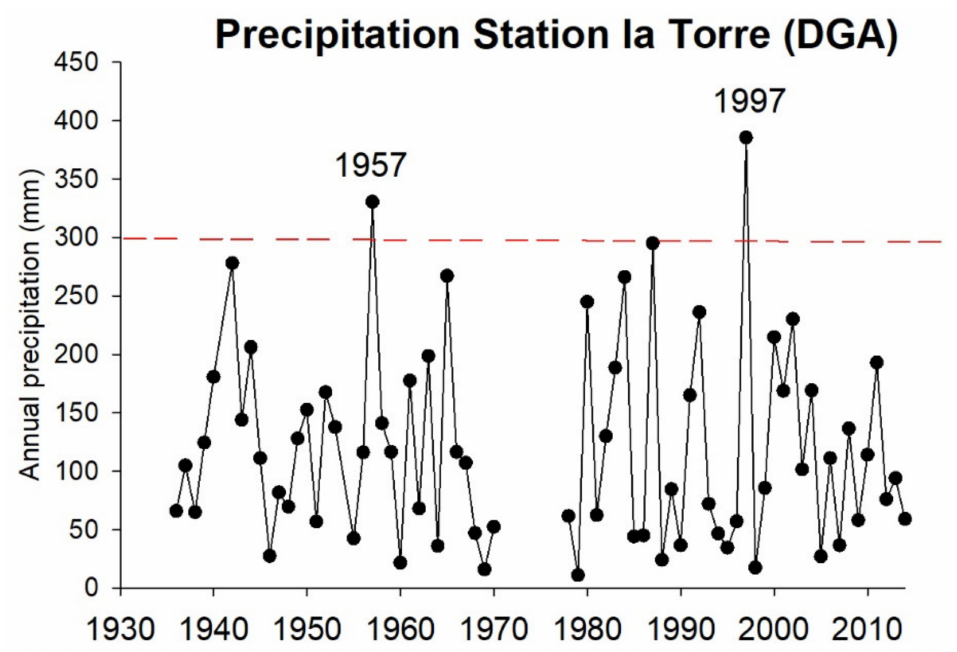
Figure A3. Record of monthly rainfall station la Torre, station closest to the study